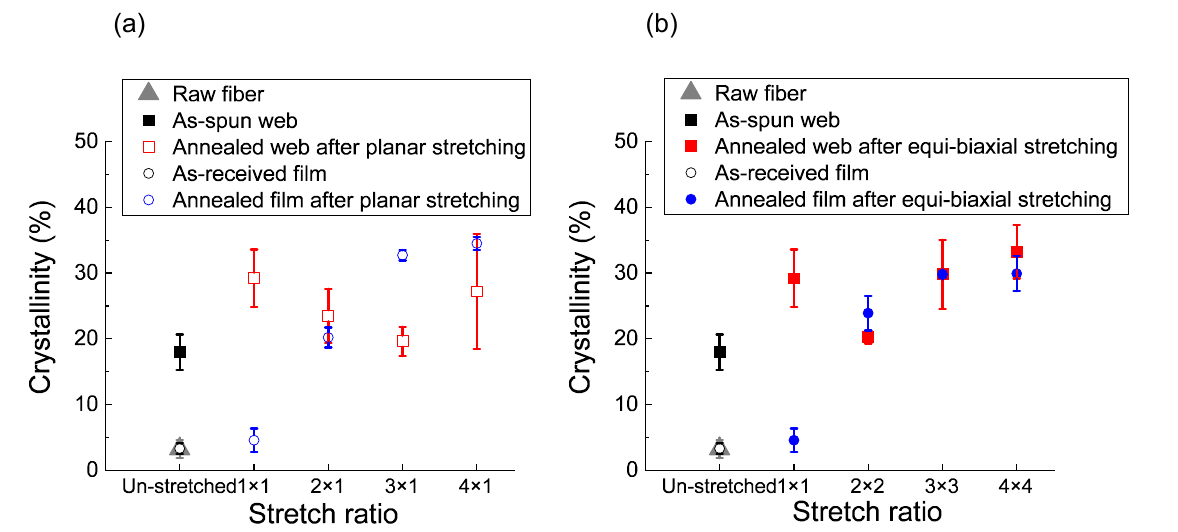
Figure 7. Crystallinity analyzed from DSC thermograms for the web and film samples prepared by annealing after ( a ) planar stretching and ( b ) simultaneous equibiaxial stretching. Data for the raw fiber for LES, as-spun web, and as-received film are also included.